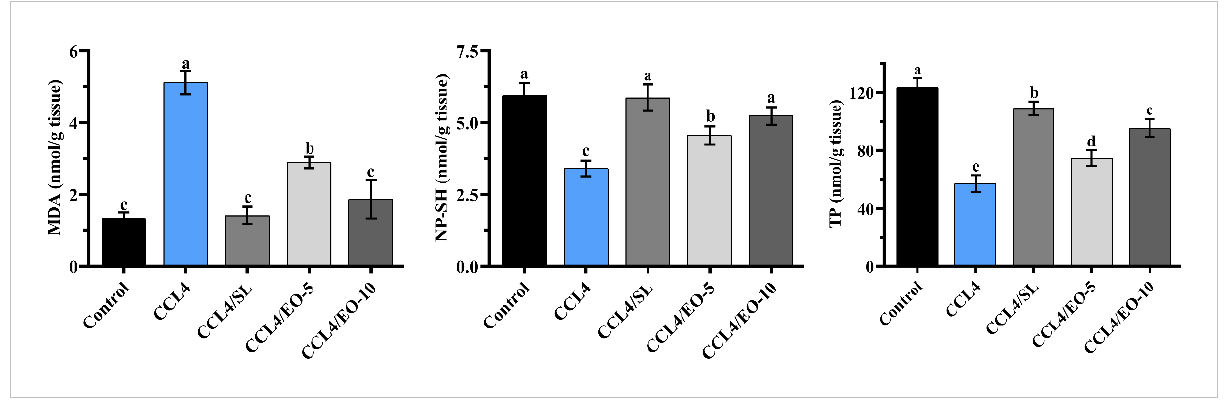
Figure 5. Effect of EO extracted from T. patula on MDA, TP, and NP-SH in liver of rats treated with CCL 4 . Data represented as mean ± SD ( n = 6). CCL 4 : Carbon tetrachloride; SL: Silymarin; EO-5: Es- sential oil (5 mg/kg BW); EO-10: Essential oil (10 mg/kg BW); MDA: Malondialdehyde; TP: Total protein; NP-SH: Non-protein sulfhydryls. Different letters indicate statistically significant differ- ences between groups at ( p < 0.05).